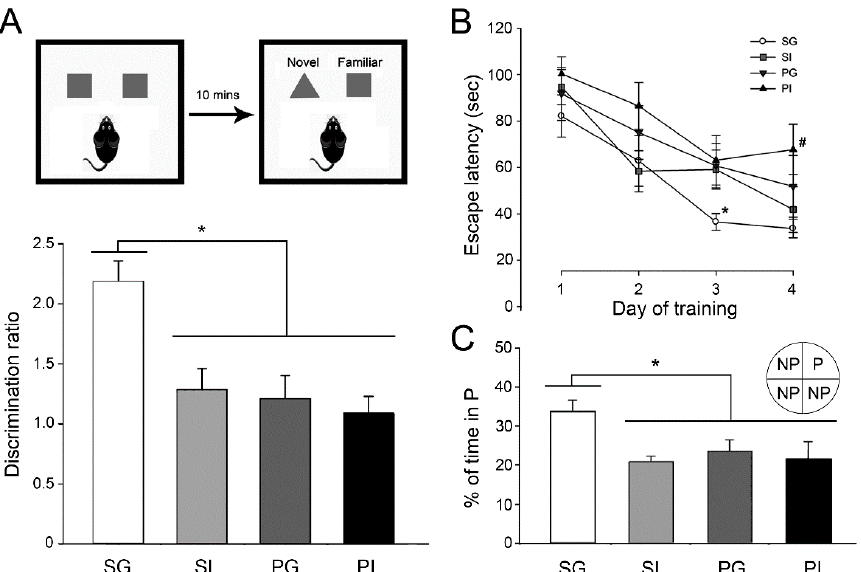
Figure 4. Tests of learning and memory. ( A ) The novel object recognition test paradigm was used to evaluate short-term object recognition memory. ( B ) Spatial learning and memory were evaluated using the Morris water maze test. ( C ) Spatial memory was evaluated in the probe test, in which the platform was removed. P: platform region during the training phase. NP: non-platform region. Results are mean ± SEM ( n = 6–10 per group). * p < 0.05. # p < 0.05 compared to the SG